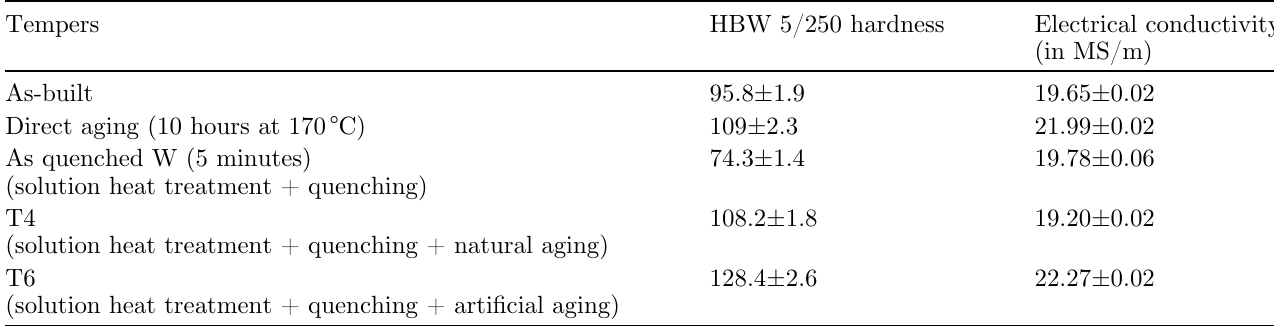
Table 4. HBW hardness and electrical conductivity of various tempers of the AlSi5Cu3Mg